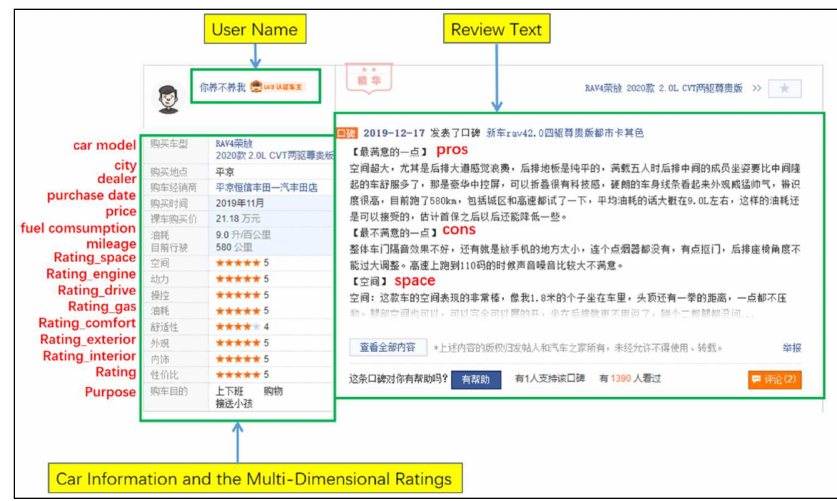
Figure 2. A sample of eWOM for Toyota RAV4 on Autohome.